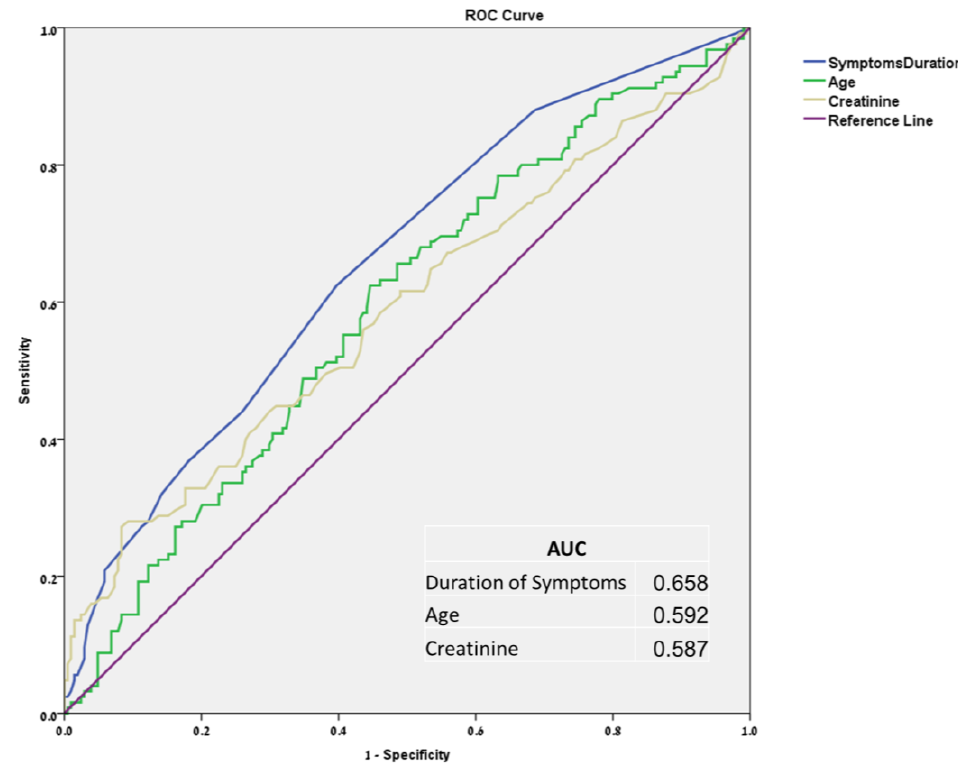
Figure 1. Receiver operating characteristic curves and area under the curve for symptoms duration, age, and serum creatinine level. Table 3. Multivariate analysis of predictors for surgical intervention. Boldface indicates statistically significant factors.